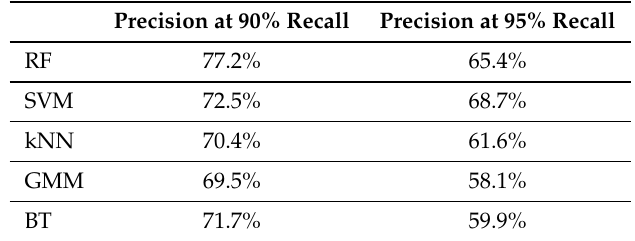
Table 1. Best Result for Each of the Tested Classifiers with Texture Features.